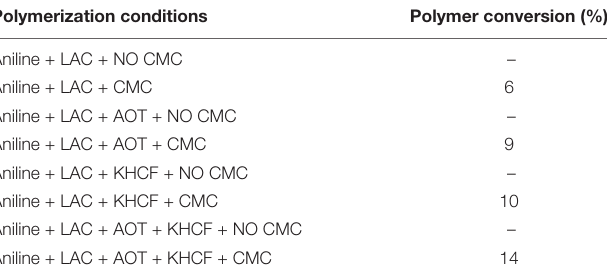
TABLE 1 | Percentage of oligomer/polymer conversion yield increment (%) after polymerization of aniline in presence of CMC under different conditions (calculated from weight of polymer obtained after oxidation and subsequent